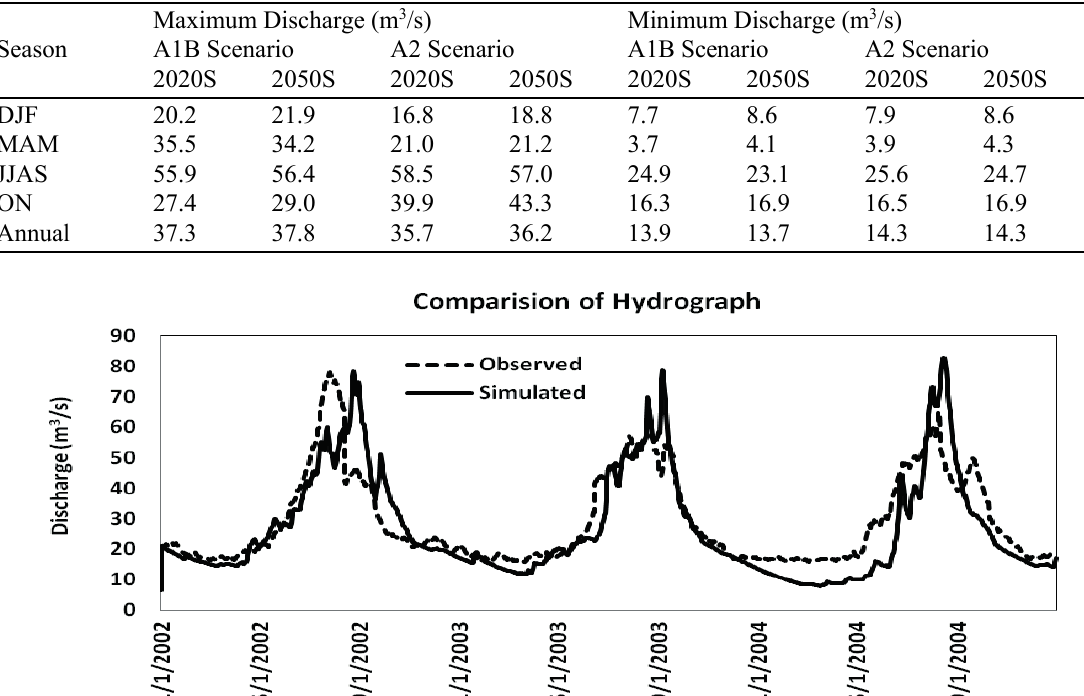
Table 4 Maximum and minimum discharge scenario.